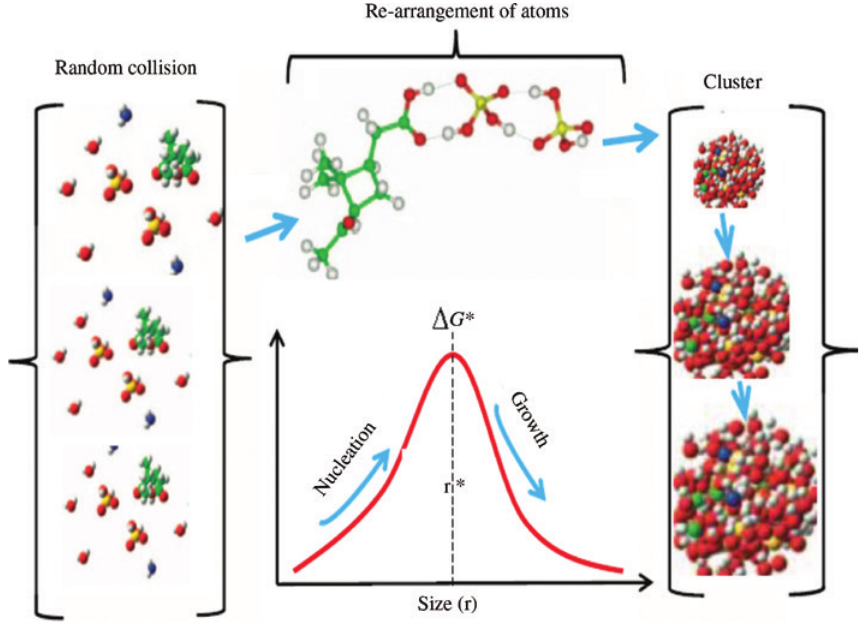
Figure 7: Nucleation and cluster formation of nanocrystals showing the random collisions, re-arrangement of atoms, and